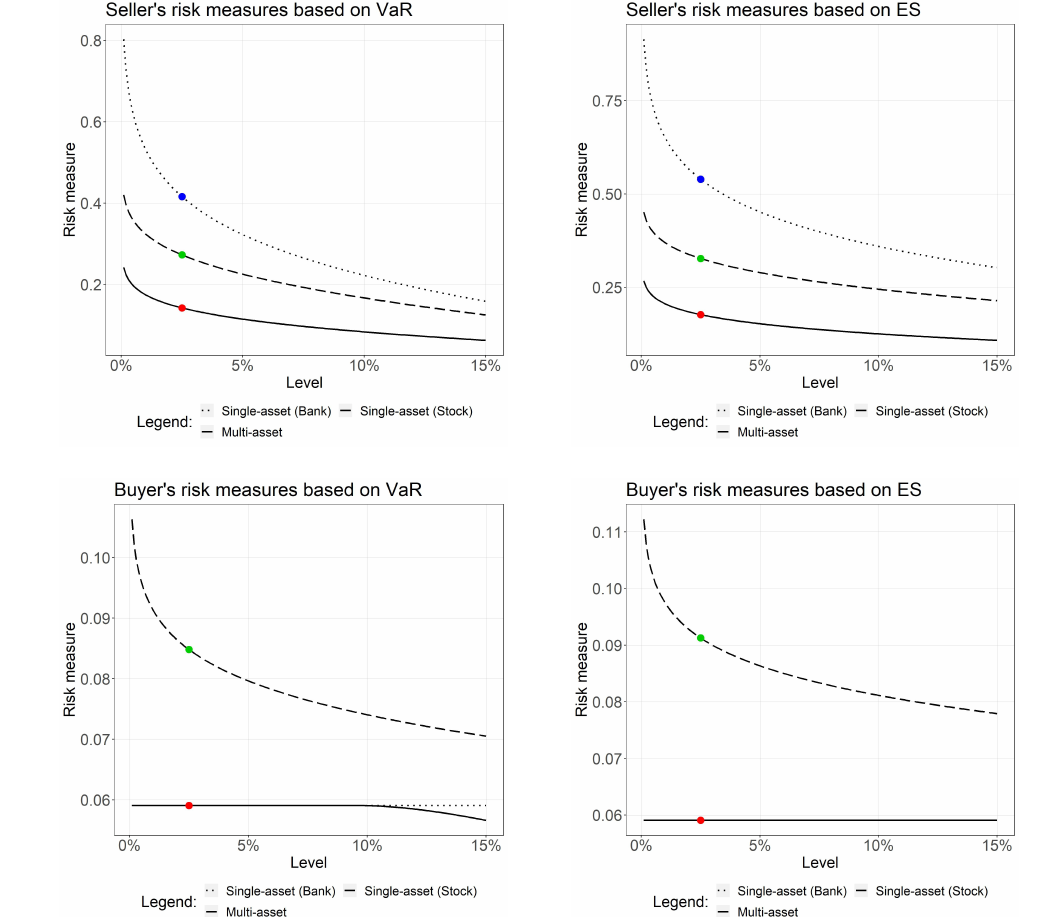
Figure 1. Single-asset and multi-asset risk measures depending on the level λ .